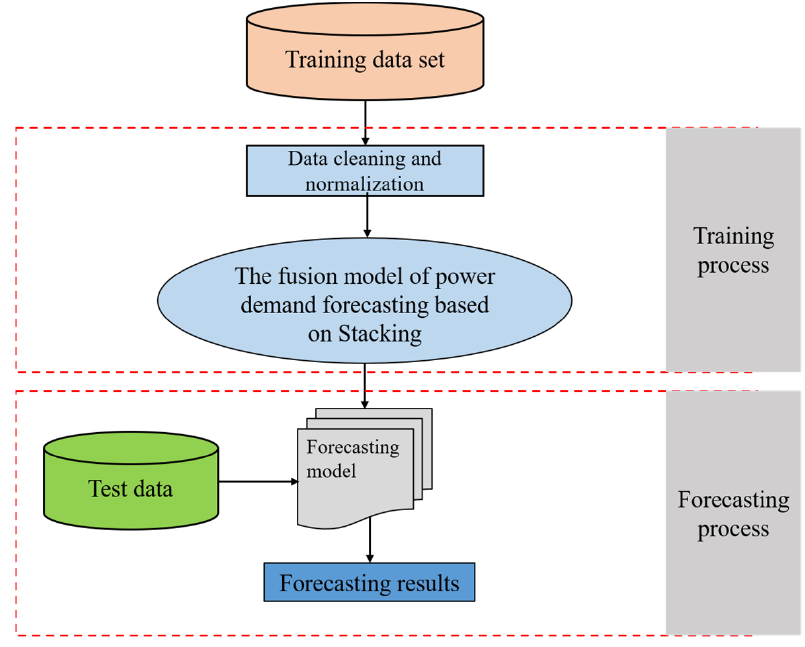
Figure 4. Model Training and the Overall Process of Forecasting.